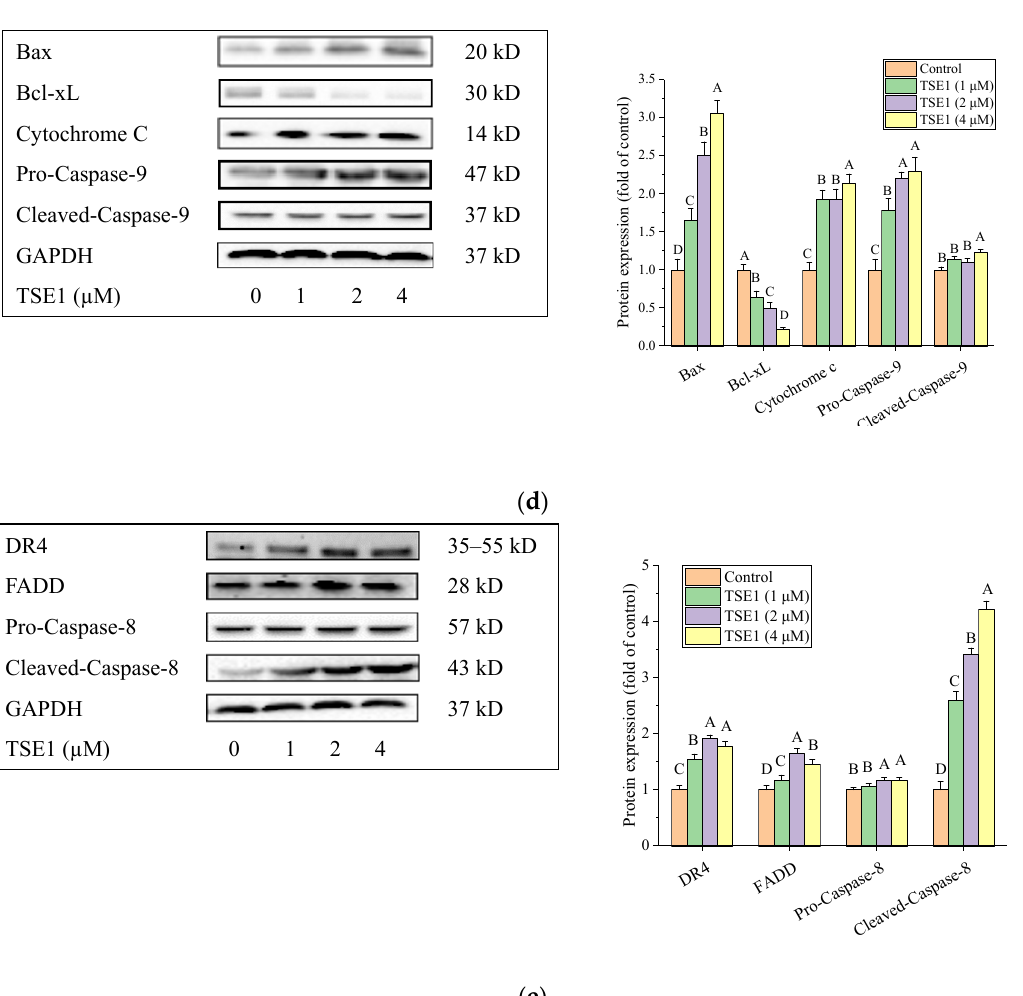
Figure 2. TSE1 induced apoptosis in OVCAR-3 cells after 24 h treatment. ( a ) Hoechst 33342 staining of OVCAR-3 detected by fluorescent microscopy (×400). ( b ) Flow cytometric analysis of OVCAR-3 cells using a double staining method with Fluorescein isothiocyanate (FITC)-conjugated Annexin V and PI. ( c ) Protein expressions of cell apoptosis and DNA damage markers including pro/cleaved-Caspase-3, pro/cleaved-Caspase-7, pro/cleaved-Poly (ADP-ribose) polymerase (PARP) andphospho-Histone H2A.X (Ser139). ( d ) Protein expressions of intrinsic apoptotic pathway-related proteins including Bax, Bcl-xL, Cytochrome C and pro/cleaved-Caspase-9. ( e ) Protein expressions of extrinsic apoptotic pathway-related proteins including DR4, FADD and pro/cleaved-Caspase-8. Protein expression were analyzed by Western blot. Results were expressed as mean ± SD from three independent experiments. Significant differences among different treatments are marked with different letters ( p < 0.05).